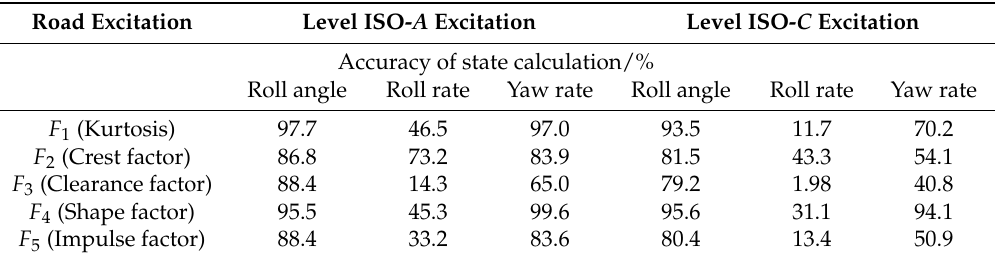
Table 5. Simulation accuracy of comparing 6-DOF model and CARSIM ® with steering wheel 10 ◦ input.